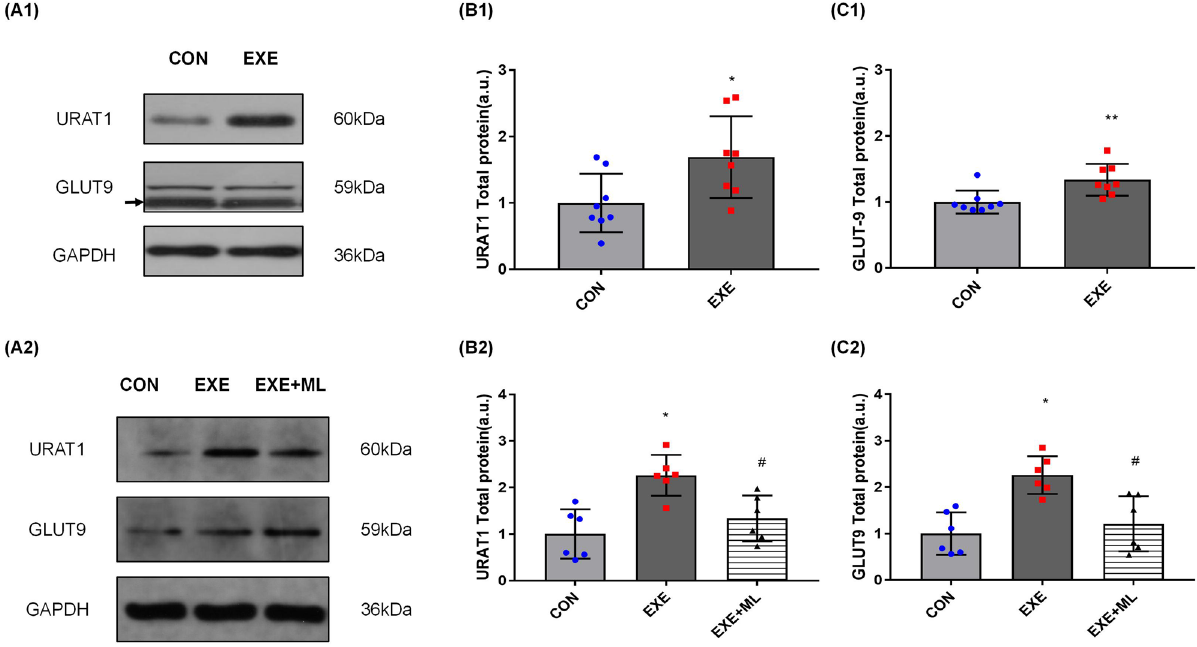
Figure 4. ( A1 – C1 ): ABCC4 and ABCG2 protein expression, normalized against GAPDH, in rat’s kidney. Data are means ± SD (n = 8). * Significantly different from CON ( p < 0.05), ** Significantly different from CON ( p < 0.01). ( A2 – C2 ): URAT1 and GLUT9 protein expression, normalized against GAPDH, in NRK-52E cells 24 h after exposure to 10% serum without exercise (CON), serum with exercise (EXE) or serum with exercise supplemented with ML385. Data are means ± SD (n = 6). * Significantly different from CON ( p < 0.05), # Significantly different from EXE ( p < 0.05).